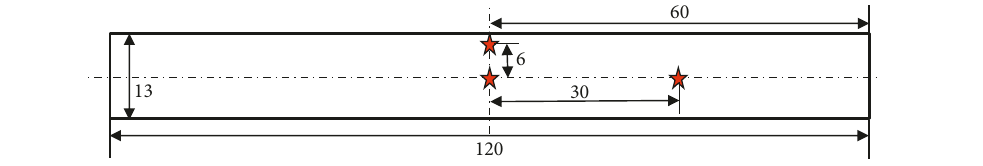
Figure 7: The location of the explosion source on the platform (unit: m). Table 2: Calculation conditions of explosions in subway